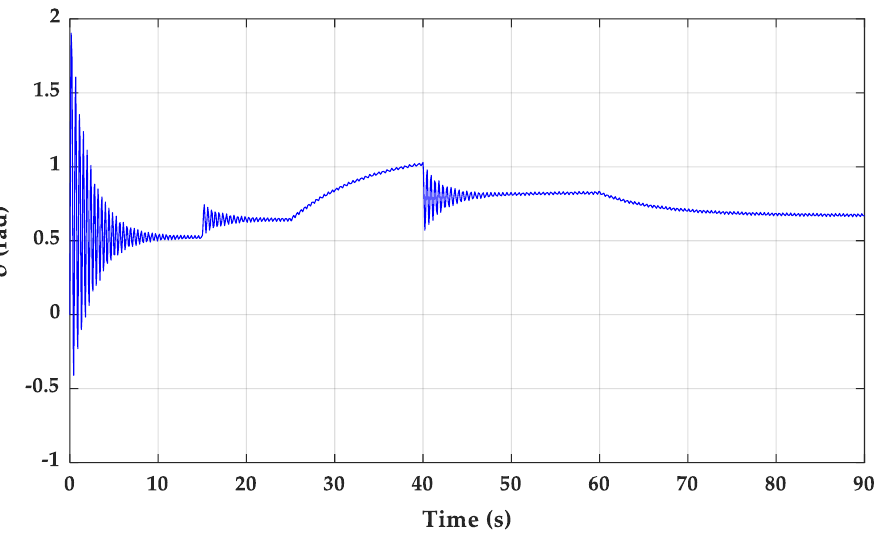
Figure 7. Response of the angular speed deviation of the SGIB with reheating.